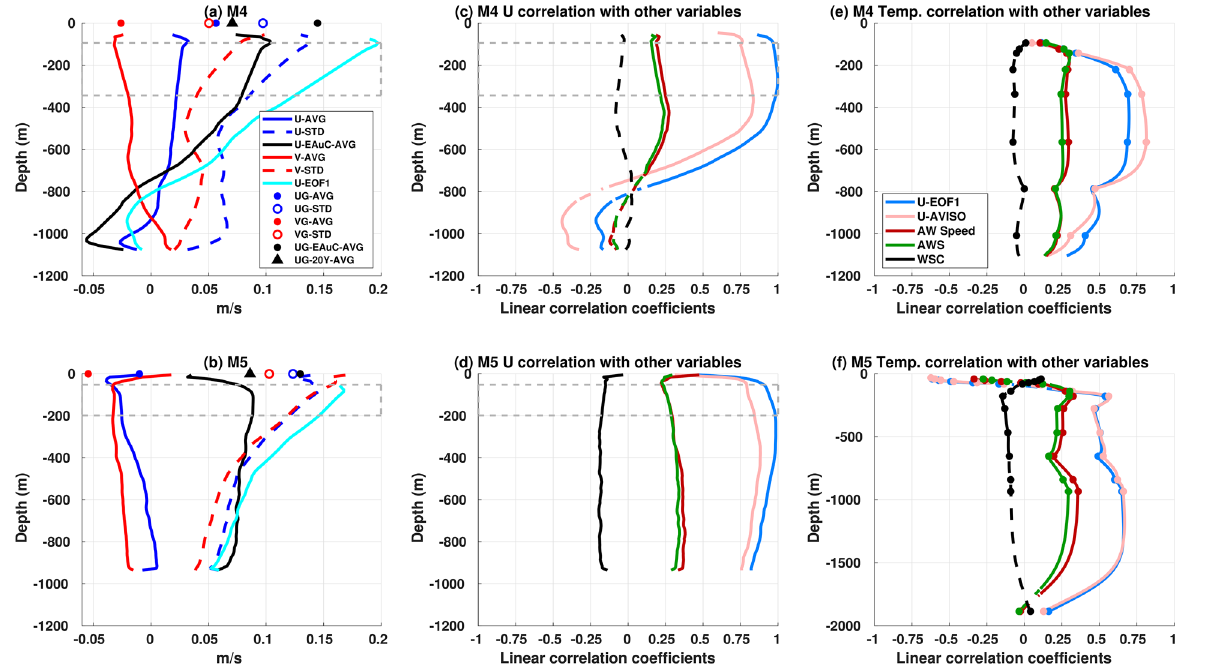
Figure 5. Average and standard deviation of along- (red) and across-slope (blue) velocities at M4 ( a ) and M5 ( b ). The solid and dashed lines represent in situ data results, whereas dots, triangles and circles represent statistics of the geostrophic velocity from AVISO. The black averages are calculated with data from 16/7 to 2/11/2015 (circles and lines) or 1993–2012 (triangles). U-EOF1 (cyan) eigenstructures (non-dimensional) are also shown. The gray-dashed rectangles show the median depths of the upper ADCP and top bin of the lower ADCP. ( c ) and ( d ) depth-resolved linear correlation coefficients between in situ along-slope velocities U-EOF1 (light blue), U-AVISO (pink), along-slope wind speed (dark red), AWS (green), or WSC (black) at M4 and M5. The dots represent the median vertical position of the temperature sensors. Correlations with p value smaller than 0.05 are represented as a dashed line. Similar correlation was applied to temperature ( e ) and ( f ). In ( f ), the depth scale varies from − 2000 to 0